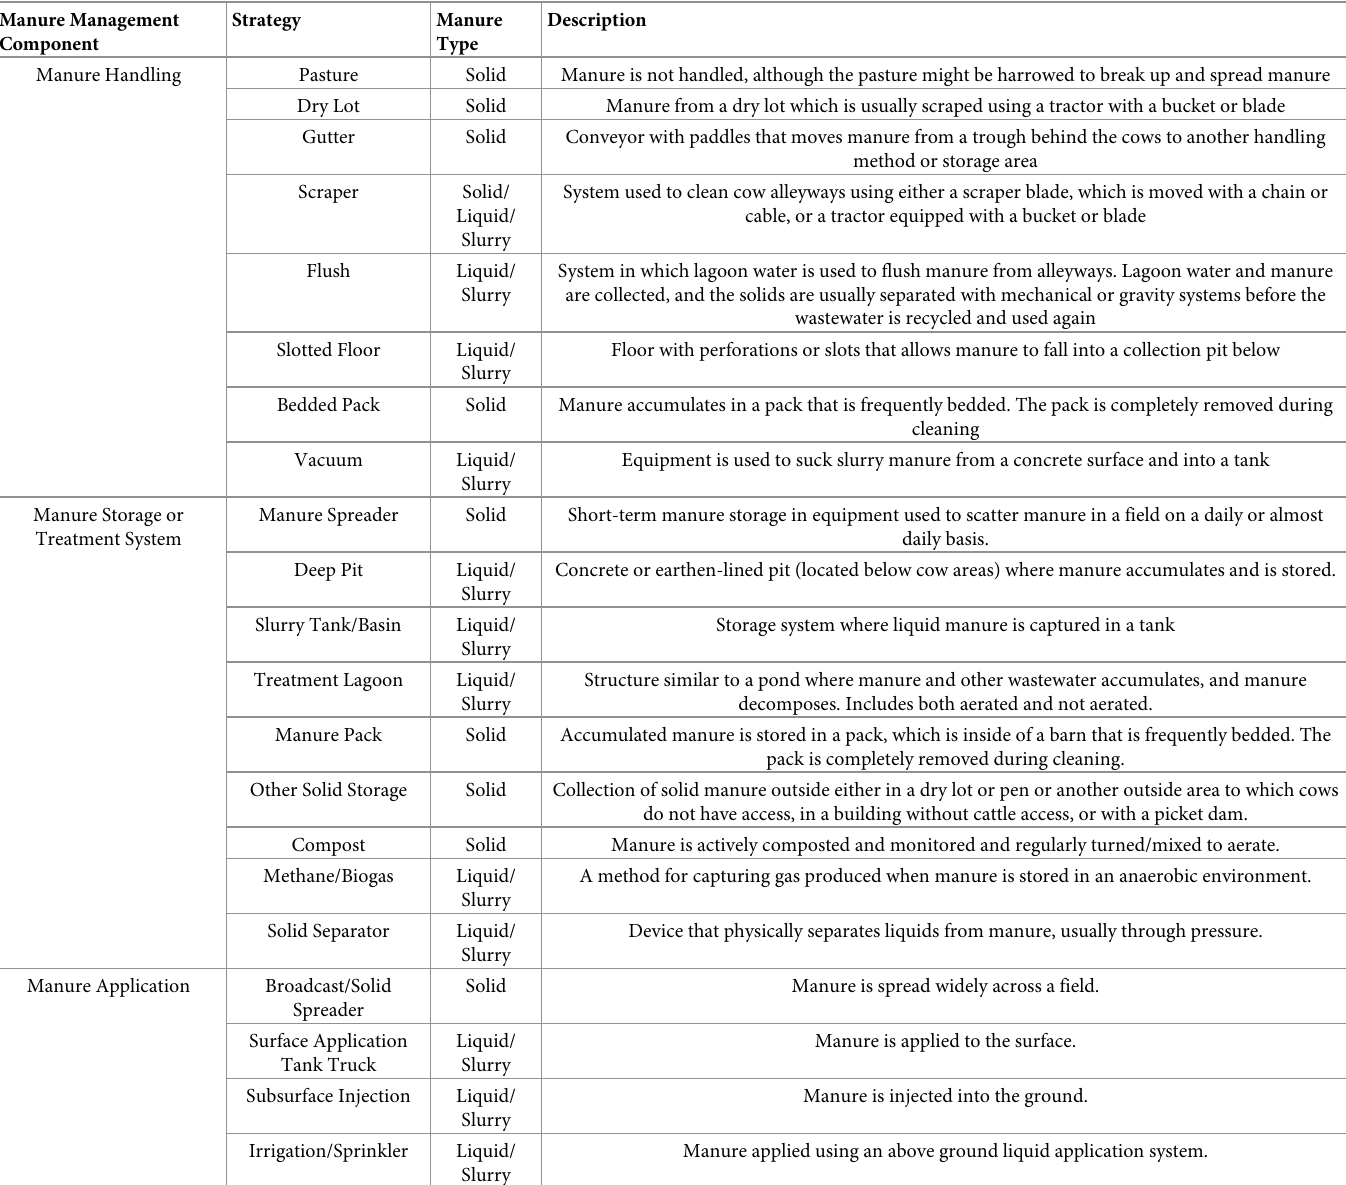
Table 1. Manure management components, strategies, and descriptions utilized in the study. Descriptions are derived from the NAHMS Dairy 2014 Report 4 [23]. Manure Management